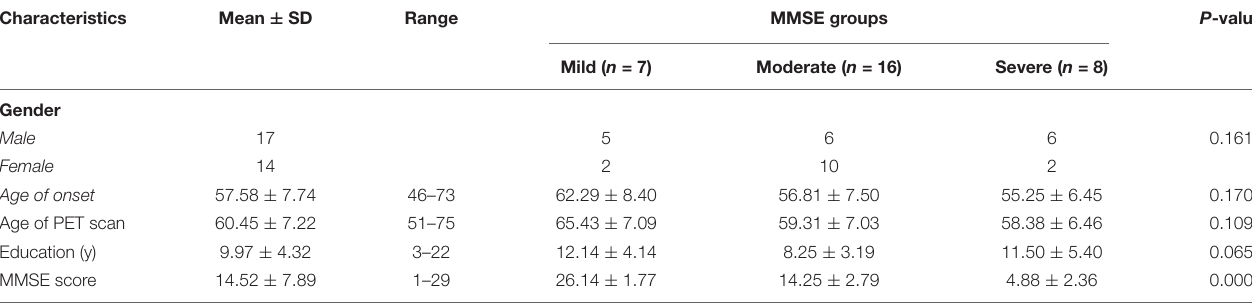
TABLE 1 | Demographic and clinical features of the